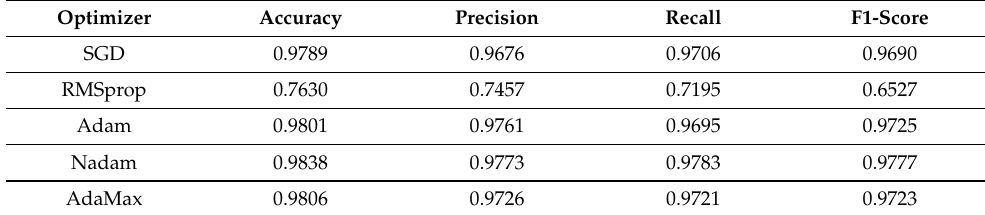
Table 6. A detailed comparison of optimizers for multi-class category classification.